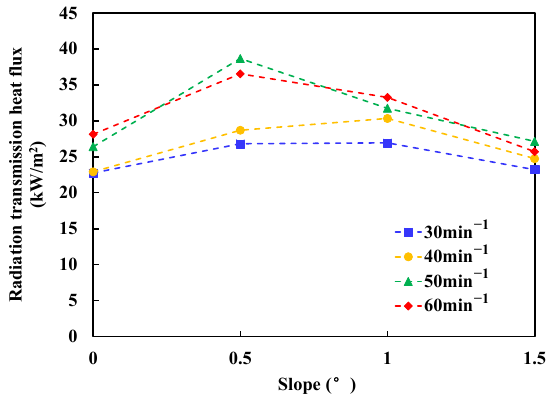
Figure 13. Variation of n-heptane flame feedback radiation transmission with slope.